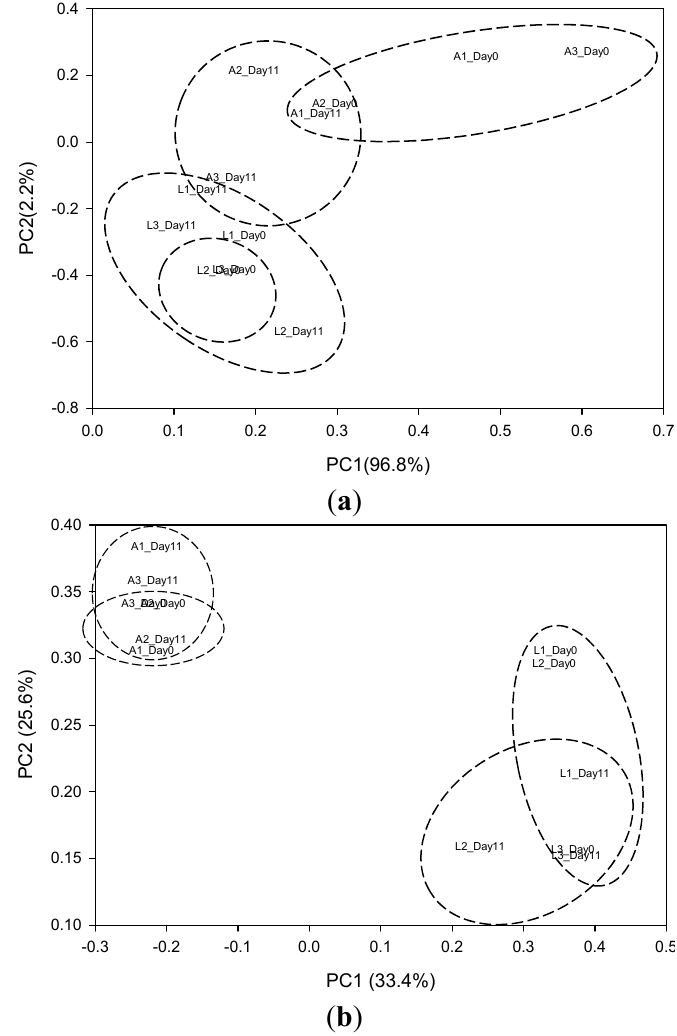
Figure 2. ( a ) Principal component analysis based on PLFA concentration and ( b ) dominant phylotypes in soil from replicates of intermittently-aerated (AIR; A1, A2, A3) and unaerated (LEACH; L1, L2, L3) leachfield mesocosms before (Day0) and after (Day11) dosing with